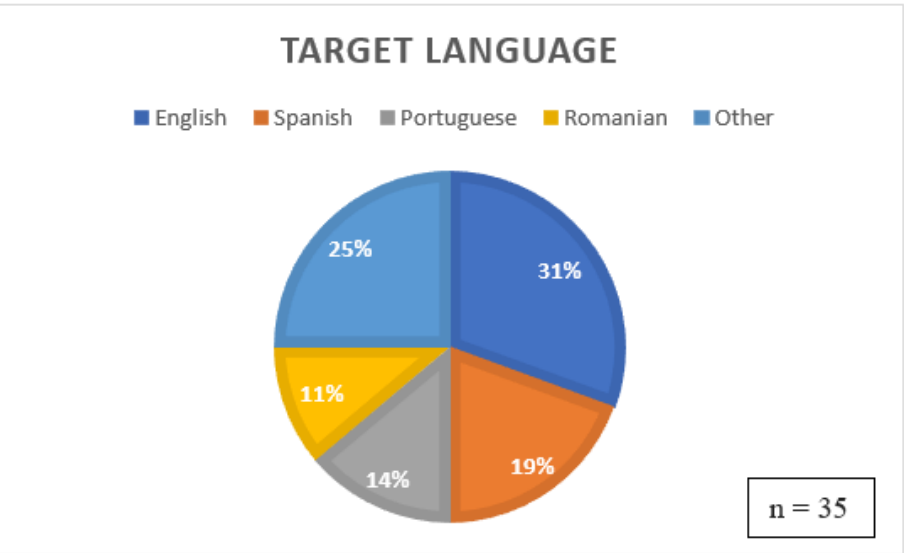
Figure 3. Overview of target languages of OST